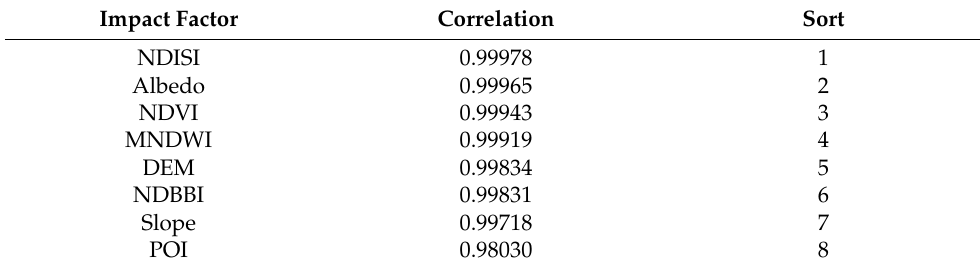
Table 8. The correlation of LST with each